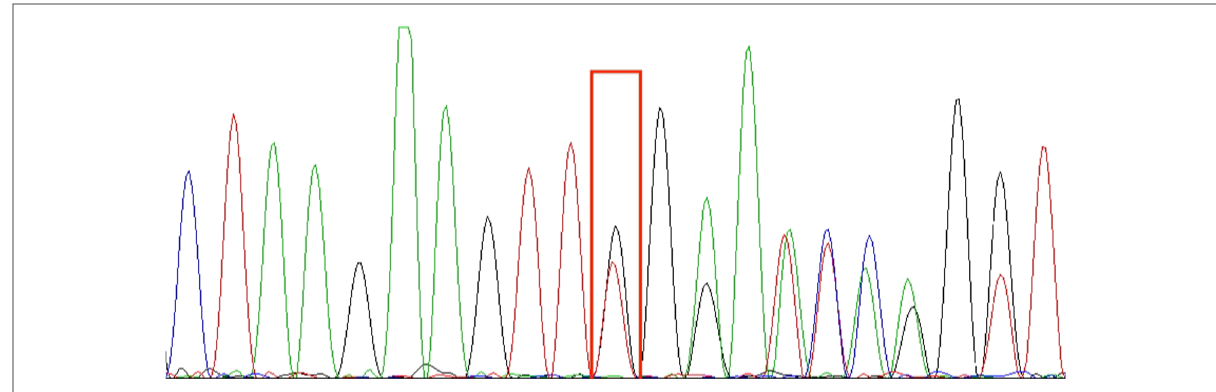
FIGURE 1 TNFAIP3 (chr6:138197151): NM_006290.3:c.653del:p.Leu218TrpfsTer10 sequencing results; red boxes are detection sites. In the picture, from top to bottom, are the fi rst witness ( A ), the father of the fi rst witness ( B ), and the mother of the fi rst witness ( C ). The genetic test results indicate that the TNFAIP3 gene variant in this pediatric patient is from the father and is a heterozygous